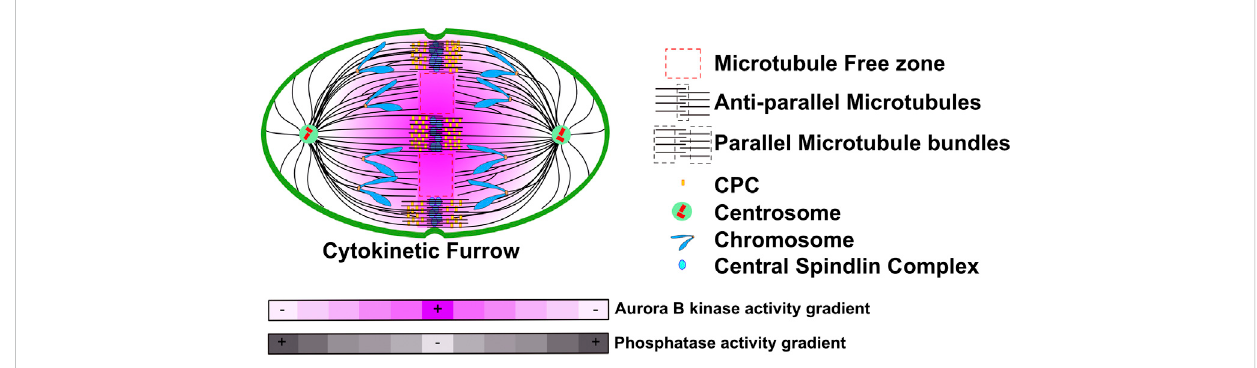
FIGURE 1 A model representation of CPC localization and Aurora B activity during anaphase. During anaphase the CPC localizes to two bundles of microtubulesin theregion betweenthesegregating chromatids. First, spindle midzones are comprisedoftwo parallel bundles of microtubulesthat have antiparallel crosslinksinthecenter. TheCPCalso binds asecondsetofmicrotubulebundles inthevicinityofcellcortexwhere thecytokinetic furrowwill form. However, there must also be soluble pools of the CPC that are not easily visualized as Aurora B activity forms gradients that emanate from these pools. These gradients are highest in the central region of the spindle and decrease toward both poles. Grey heat map represents a potential Phosphatase activity gradient that we speculate could emanate from poles. Figure representation: Cell cortex, green; Spindle poles, green circle; Centrioles, red cylinders; Chromosome arms, blue; Kinetochores, Orange rectangles; Microtubules, black lines; Central Spindlin complex, blue ovals; CPC, yellow rectangles; Parallel and Antiparallel microtubule crosslinks are highlighted within dash black lines; Microtubule free zones are highlighted within dash red lines; Pink heat map represents Aurora B kinase activity gradient. Abbreviation: CPC, Chromosomal Passenger